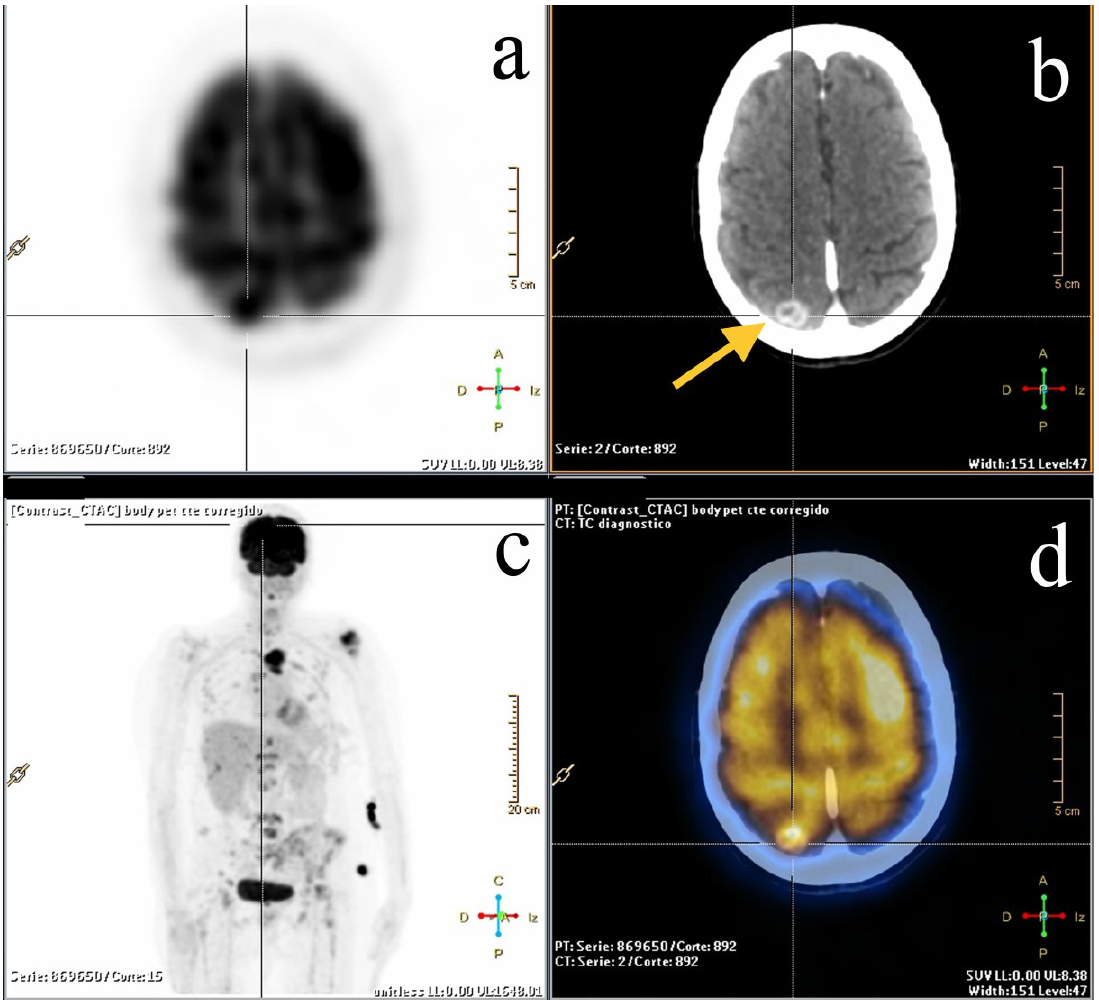
Figure 1. A 67-year-old woman with breast carcinoma and known bone metastases, but without suspicion of progression, referred for FDG-PET/CT exam. ( a ) Axial PET image showing a focus of FDG uptake in the right posterior parietal lobe; ( b ) axial CT showing a rounded lesion with contrast enhancement ring and perilesional edema (arrow); ( c )